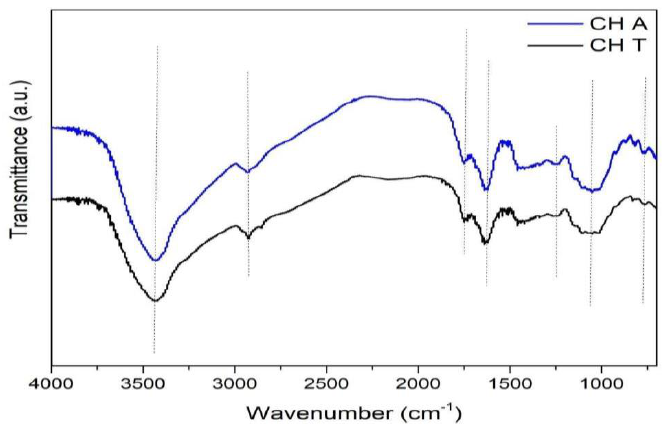
Figure 4. FTIR spectra of chañar Gums. Table 2. Principal absorbance bands of FTIR spectra of CHT and CHA gums [46,58 – 63].